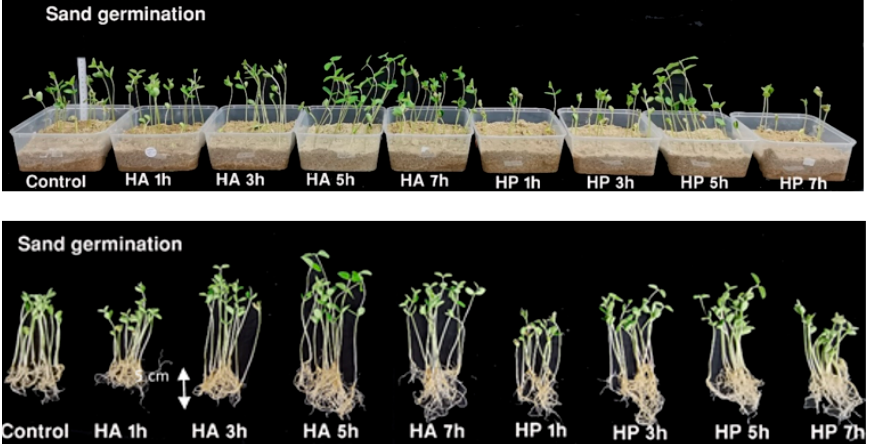
Figure 1. The seedling growth comparison due to different priming treatment at seven days after seed sowing under laboratory (sand germination) condition. Table 4. Effect of the priming treatments on germination related traits in soybean. Treat.